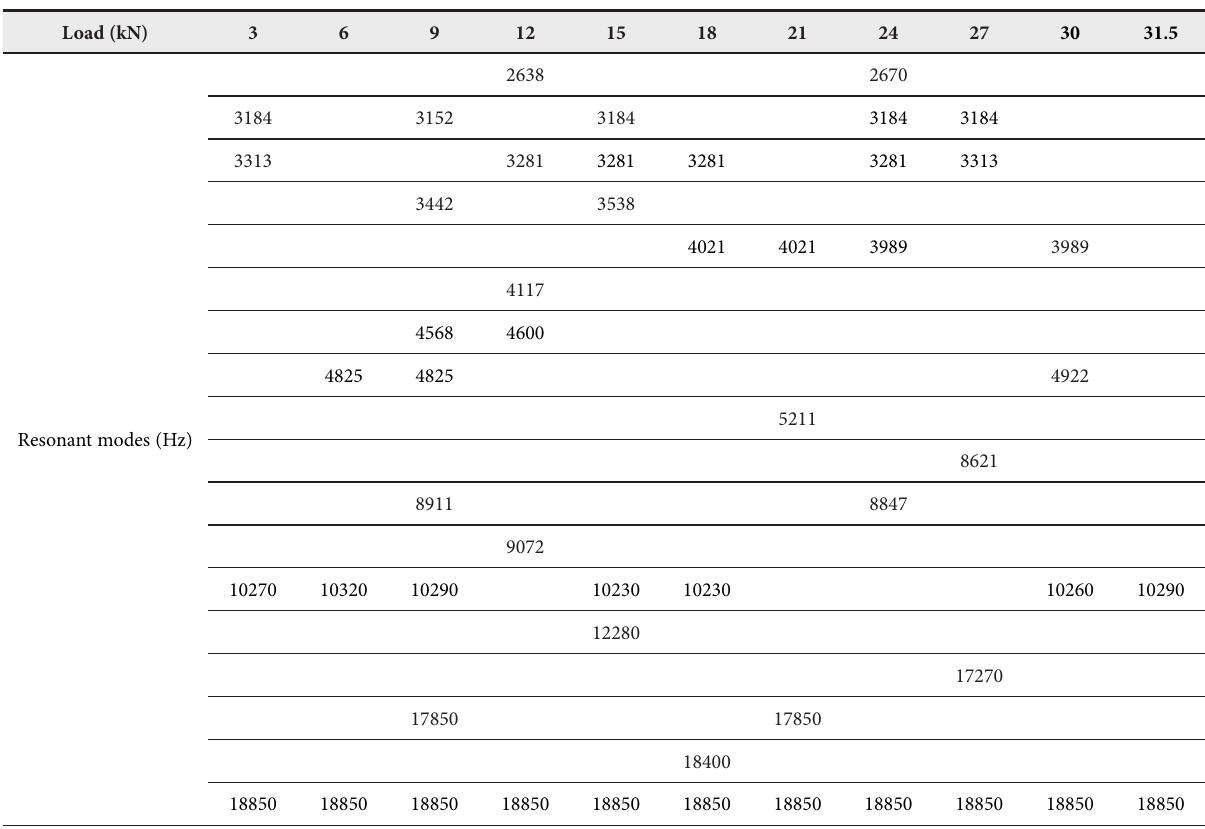
Fig. 9. The example of spectrum of resonant modes at 15 kN load. Window size: 2048 samples, windowing type: Blackmann-Harris Resonant modes at the particular load